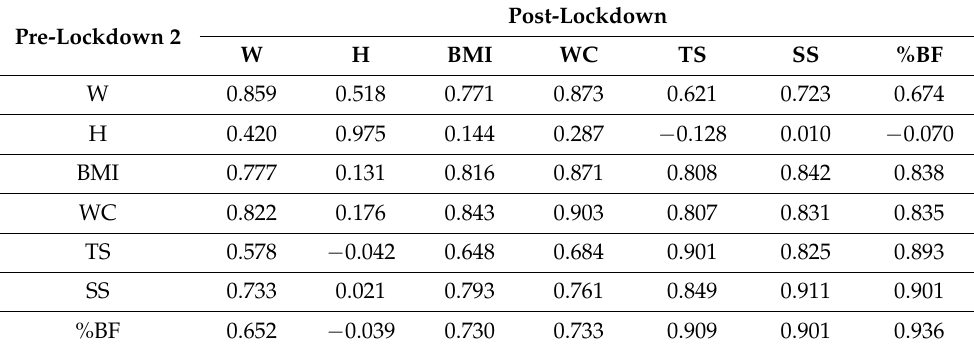
Table 4. Correlation results of pre-confinement and post-confinement anthropometric